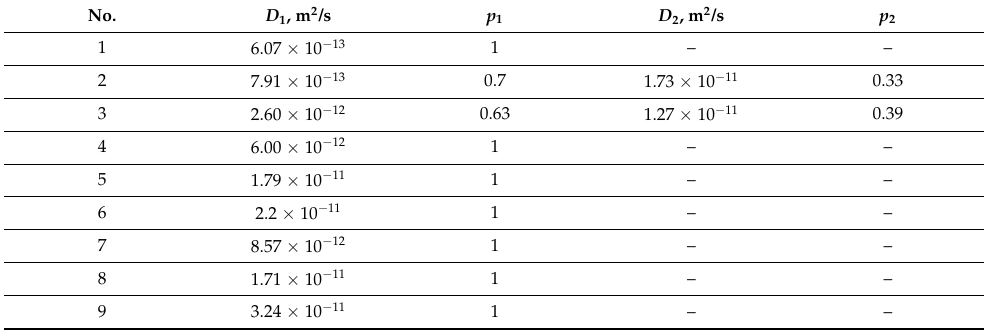
Table 7. 19 F self-diffusion coefficients